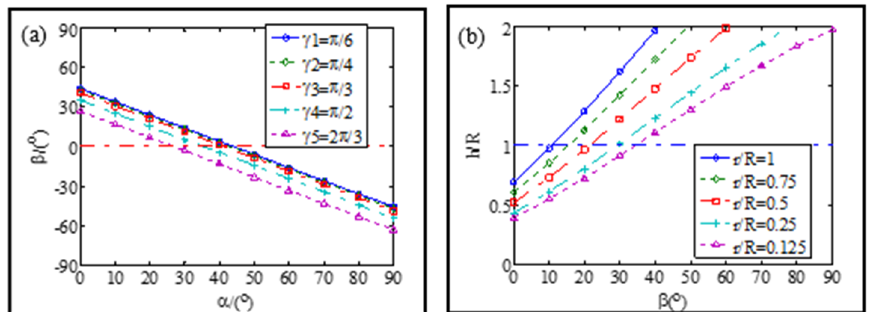
Figure 6. ( a ) The relation of the pressure angle ( α ) and the load distribution angle ( β ) with various hook angles ( γ ), ( b ) the relation of the load distribution load angle and the particles’ sizes on the contact surface with different sizes of hooks.